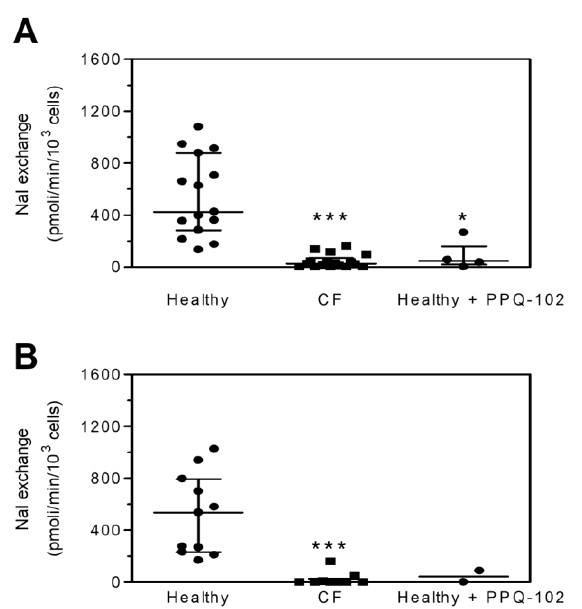
Figure 1. Detection of cystic fibrosis transmembrane conductance regulator (CFTR) activity in peripheral blood mononuclear cells (PBMCs). ( A ) CFTR activity was measured in PBMCs freshly isolated from healthy donors, in the absence ( n = 15) or in the presence of 10 µ M CFTR inhibitor PPQ-102 ( n = 4), and cystic fibrosis (CF) patients F508del +/+ ( n = 17). ( B ) CFTR activity was measured in monocytes isolated from healthy donors, in the absence ( n = 11) or in the presence of 10 µ M CFTR inhibitor PPQ-102 ( n = 2), and CF patients F508del +/+ ( n = 9). Data are expressed as a median with an interquartile range. Statistical analysis was carried by means of Kruskal–Wallis test followed by Dunn’s multiple comparison test. *** p < 0.001; * p < 0.05.